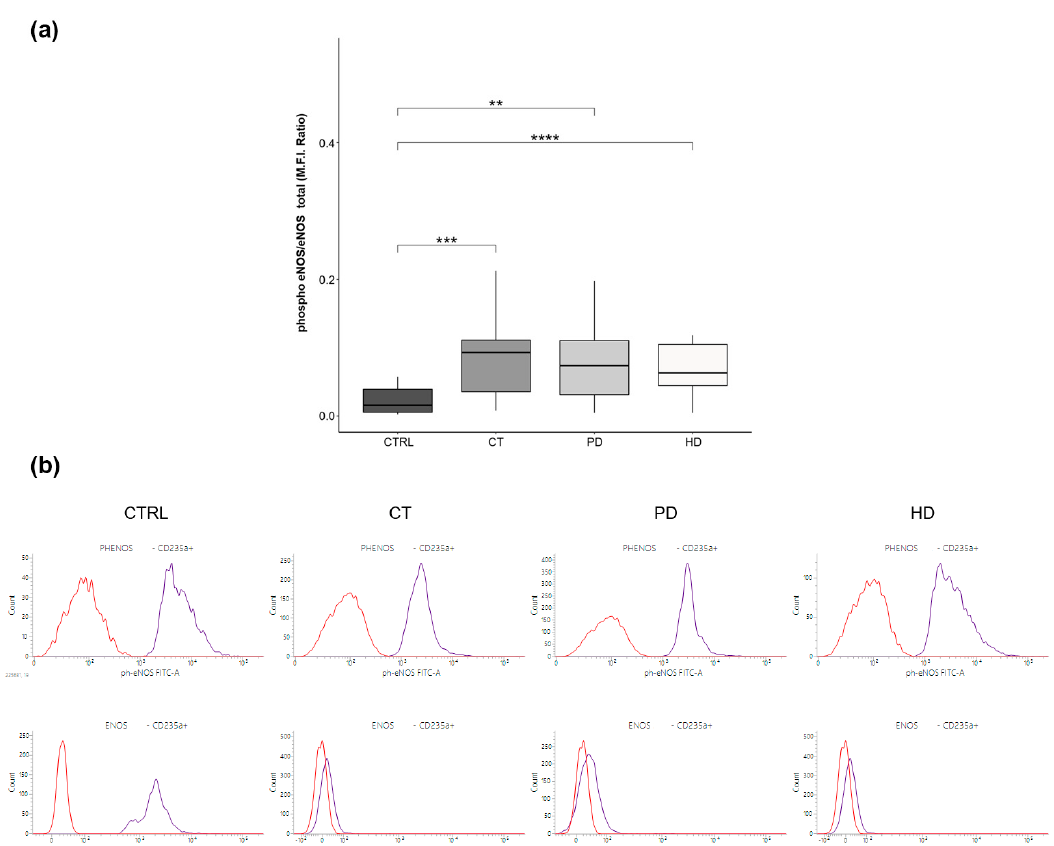
Figure 1. RBC-NOS phosphorylation levels. ( a ) Box plots represent eNOS phosphorylation (Ser-S1177) levels in the four study groups (CTRL, CT, PD, HD; N = 20 for each group). Data were obtained by flow cytometry analysis and expressed as Mean Fluorescence Intensity (MFI) Ratio of RBC ph-eNOS/eNOS. Horizontal black lines indicate the medians, boxes the interquartile range (IQR) and the bottom and top whiskers represent the minimum and maximum values. (** p < 0.01; *** p < 0.001; **** p < 0.0001). ( b ) The histograms representing RBCs stained by ph-eNOS (upper panel) and eNOS (lower panel) (blue)was overlaid to the histogram of the related controls (red) in four study groups (CTRL, CT, PD, HD).